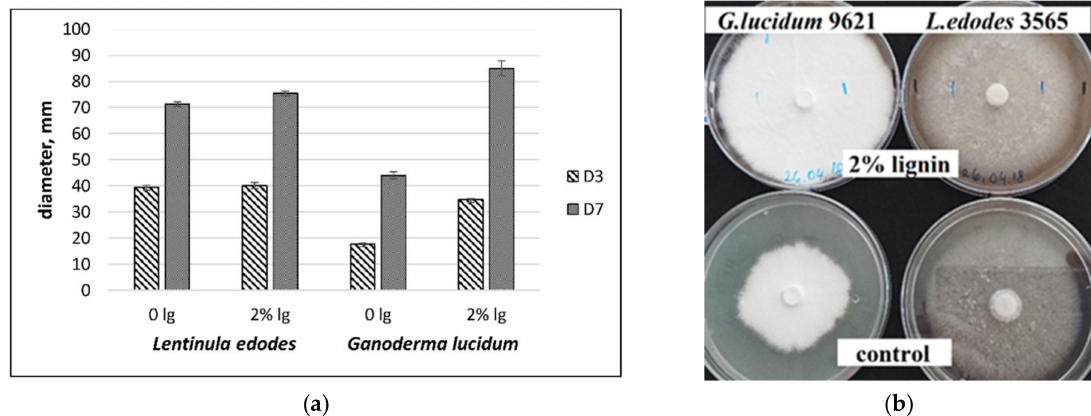
Figure 1. Diameter of mycelia grown on MEB agar and MEB + 2% CS lignin (lg). Experiments were performed in triplicate. ( a ) D3, D7–days of cultivation. ( b ) L. edodes and G. lucidum mycelial growth on solid media, cultivation period—10 days.